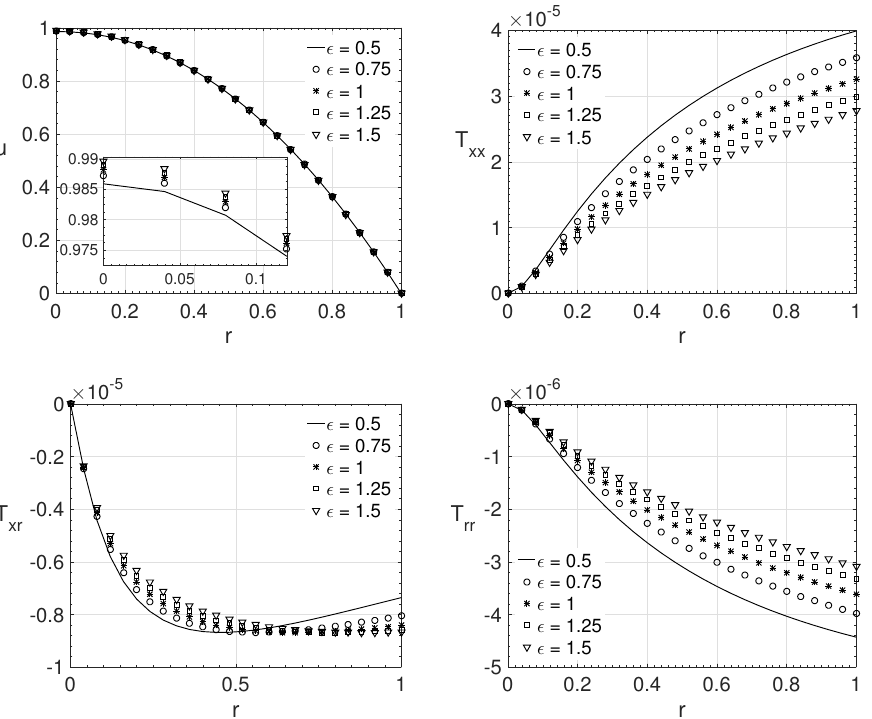
Figure 5. (cid:101) influence on the radial variation r of the streamwise velocity component u and the extra-stress tensor components T xx , T xr and T rr . Dimensionless parameters: Re = 6000, β = 0.75, ξ = 0.2 and Wi = 4.